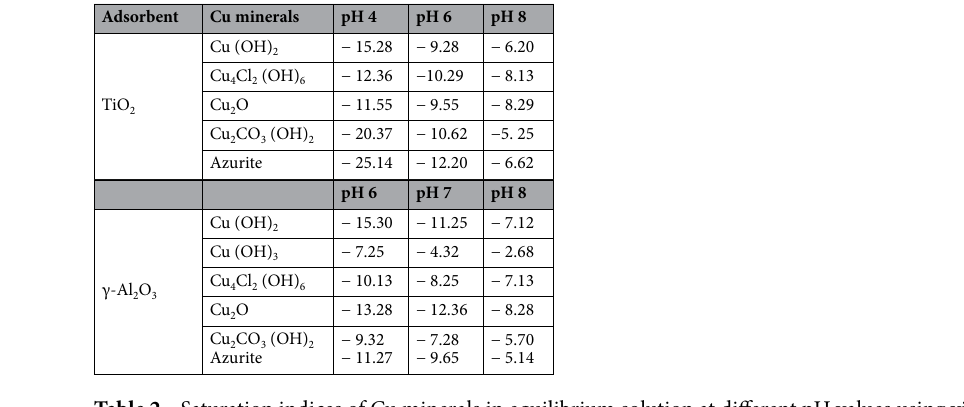
Table 2. Saturation indices of Cu minerals in equilibrium solution at different pH values using visual MINTEQ (ionic strength 0.01 M CaCl 2 ) .